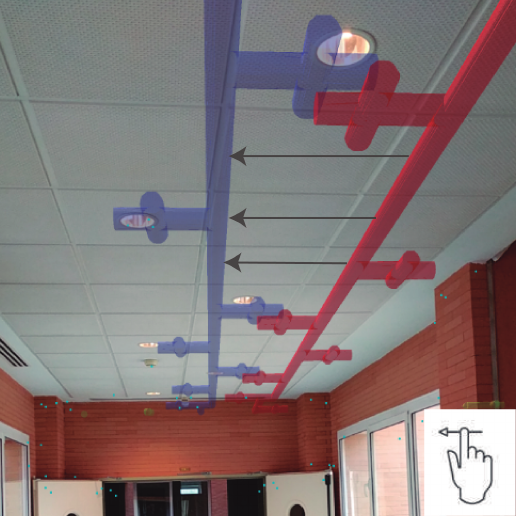
Figure 17. Updating process to change the position of a light